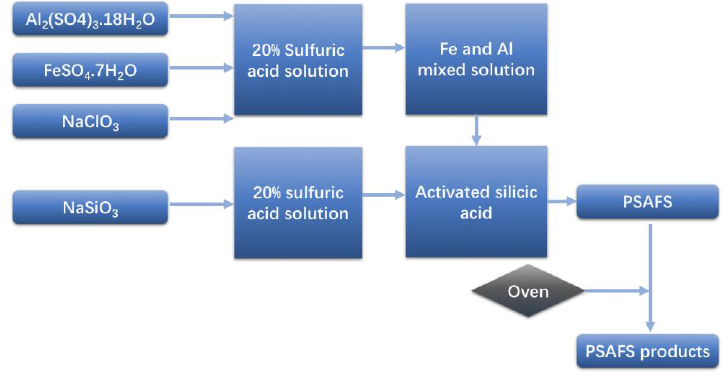
Figure 1. Preparation of polysilicate aluminum ferric sulfate (PSAFS).